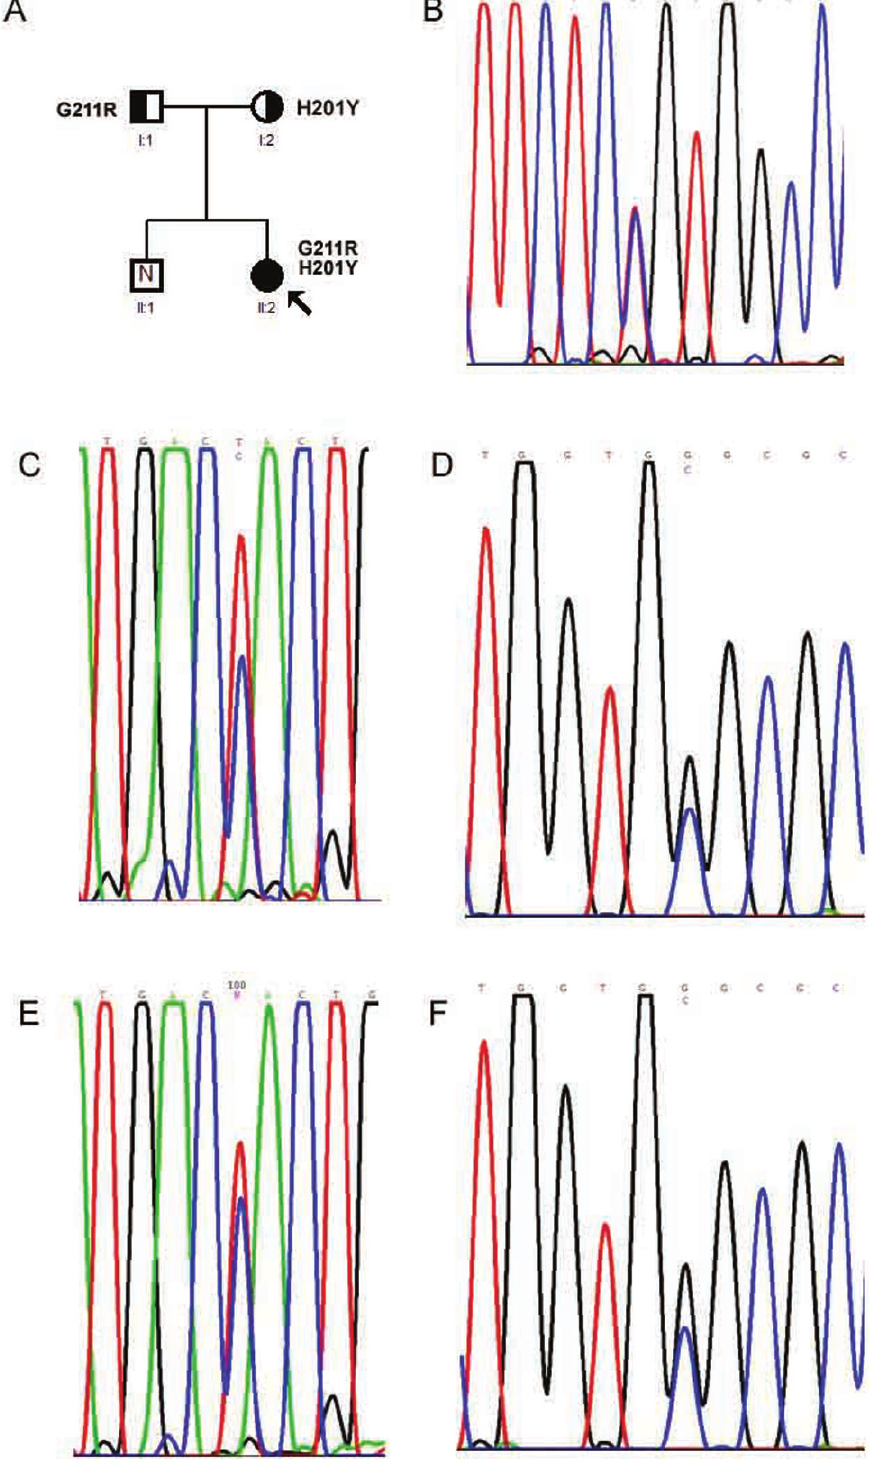
Figure 1 - (a) Pedigree of the Brazilian family with NDI; the proband is indicated by an arrow. An open square with an inset (N) indicates that the individual was unaffected. (b) c.491T . C polymorphism; (c and e) heterozygosis at c.601C . T (H201Y) of the proband and her mother; and (d and f) heterozygosis at c.697C . G (G211R) of the proband and her